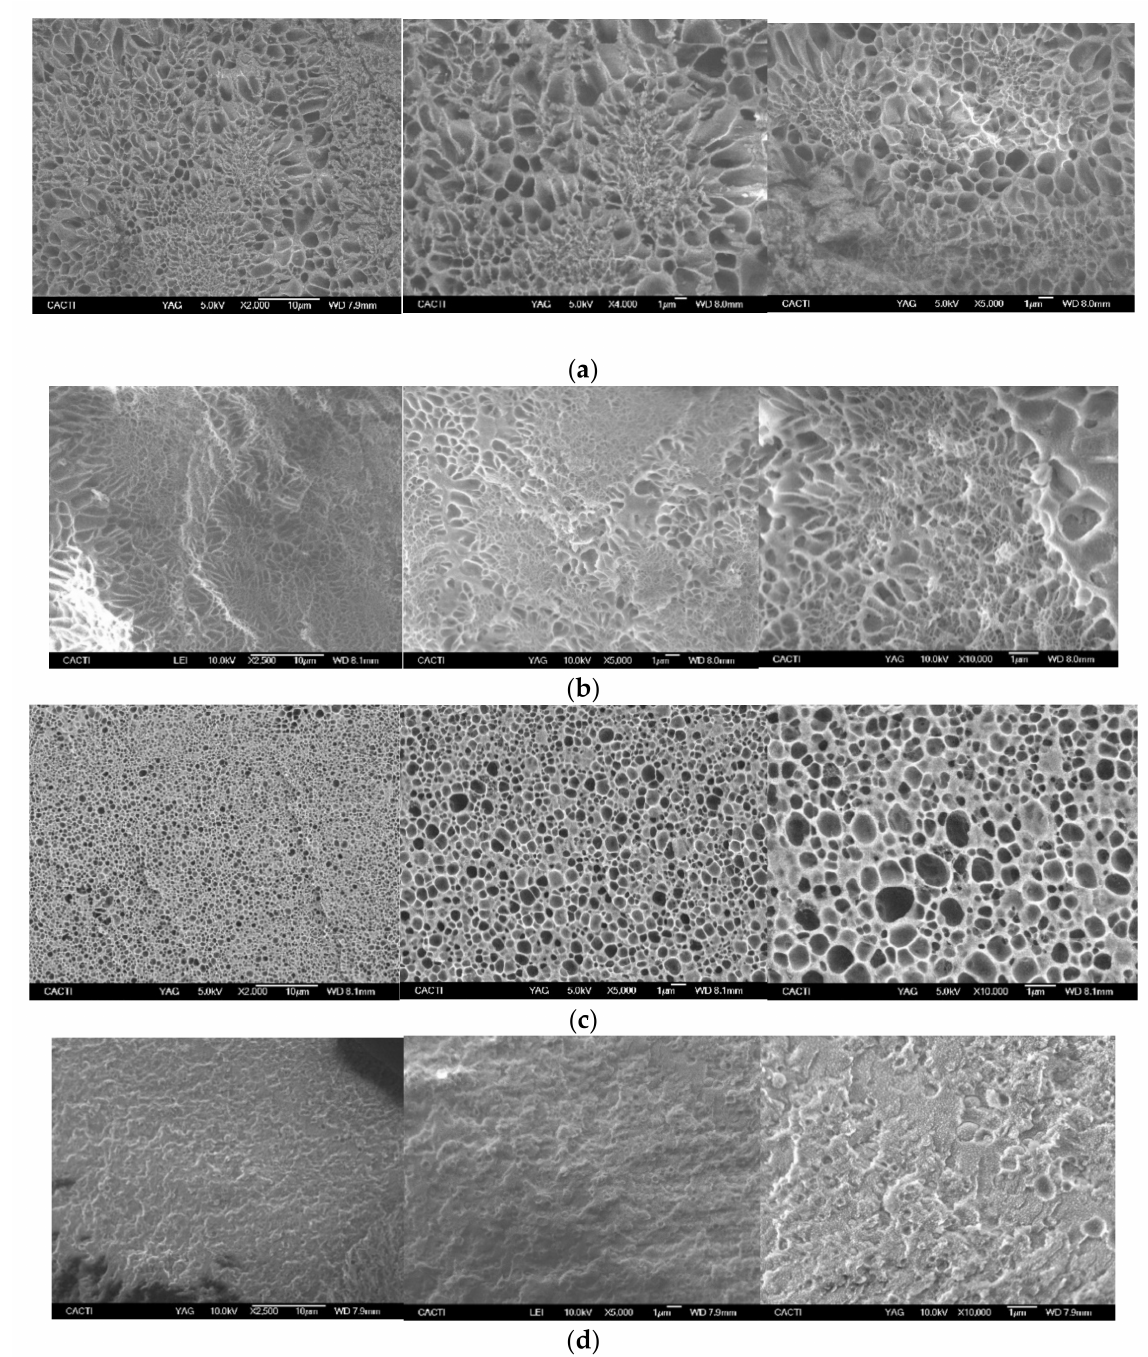
Figure 15. Cryo-scanning electron microscopy of hydrogel gelatin and Ionogels: ( a ) GE; ( b ) GE/5IL; ( c ) GE/15IL; ( d )